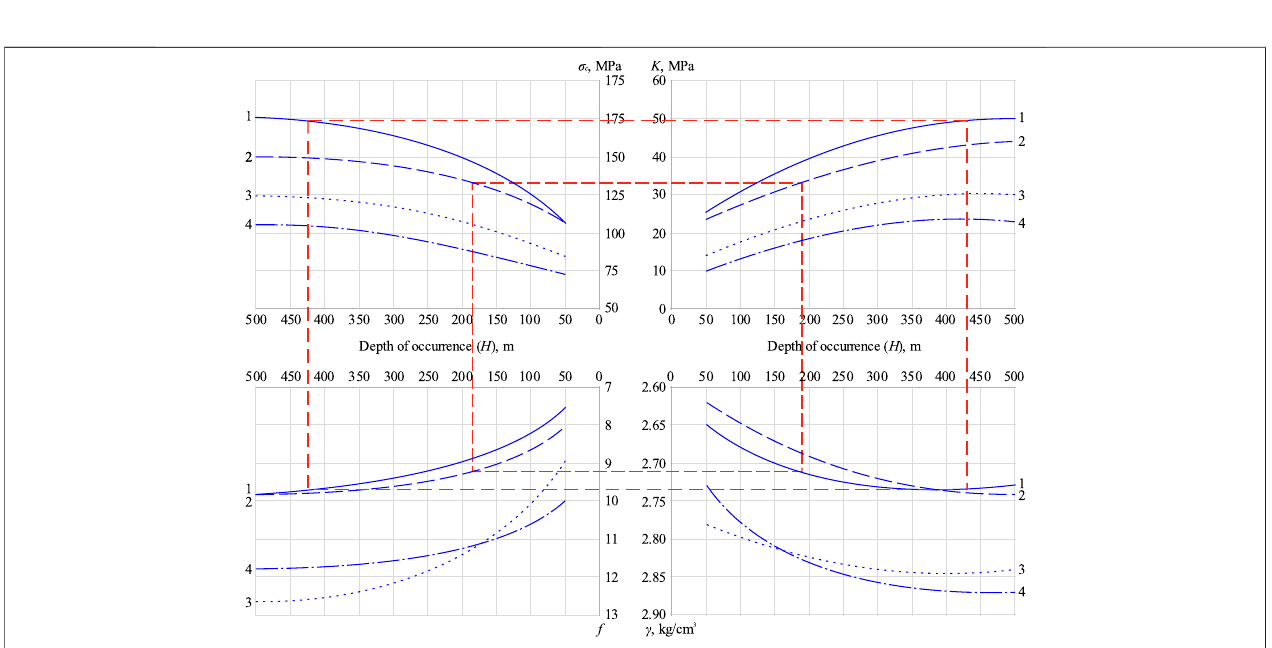
FIGURE 6 | Dependences of the rock properties on changes in the depth of their occurrence: 1, Saryoba deposit; 2, Akzhal fi eld, 3, Sayak deposit, 4, Akbakai deposit; σ c, compression strength of rocks, MPa; K, adhesion, MPa; f, rock hardness; γ , density, kg/cm 3 .